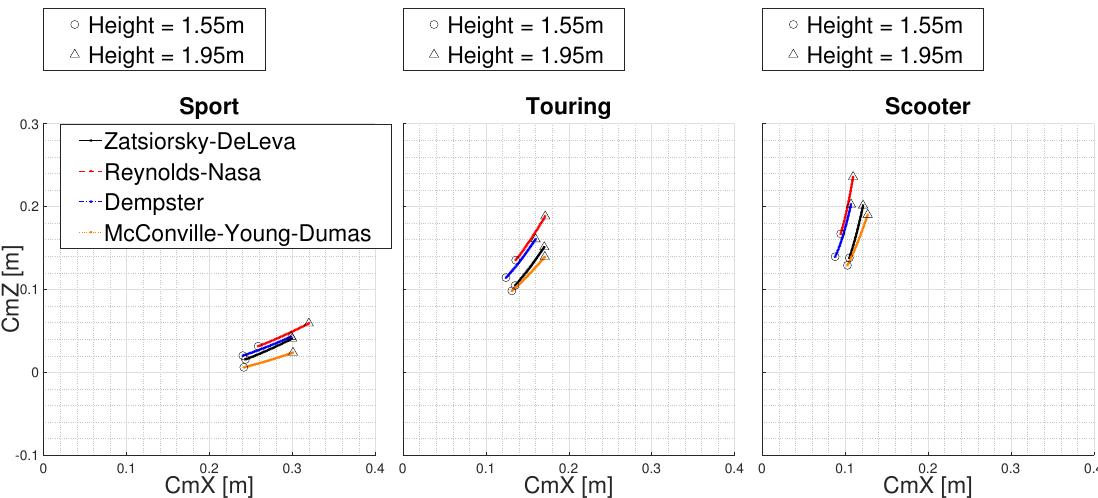
Figure 10. Position of the center of mass as a function of rider